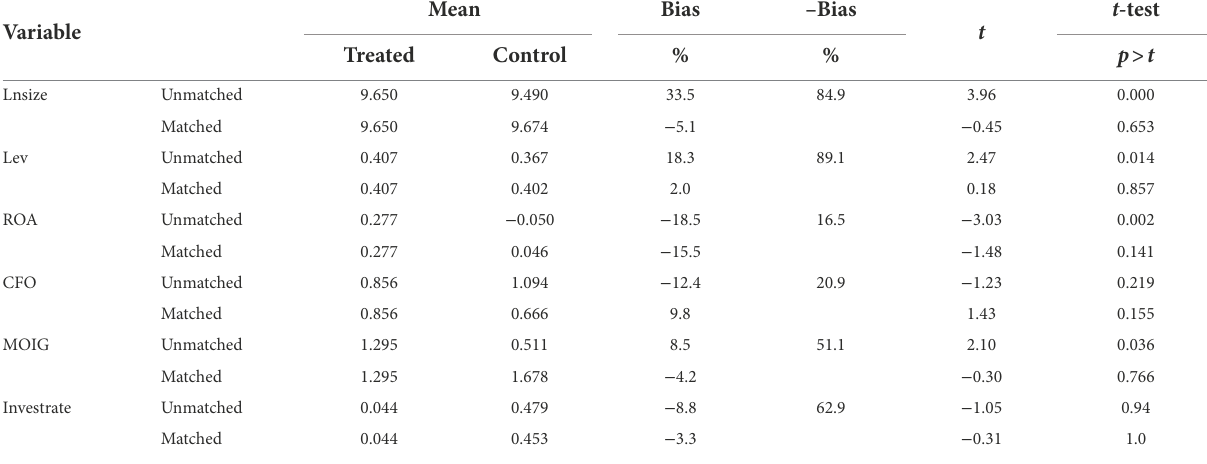
TABLE 3 Results of balance hypothesis test.